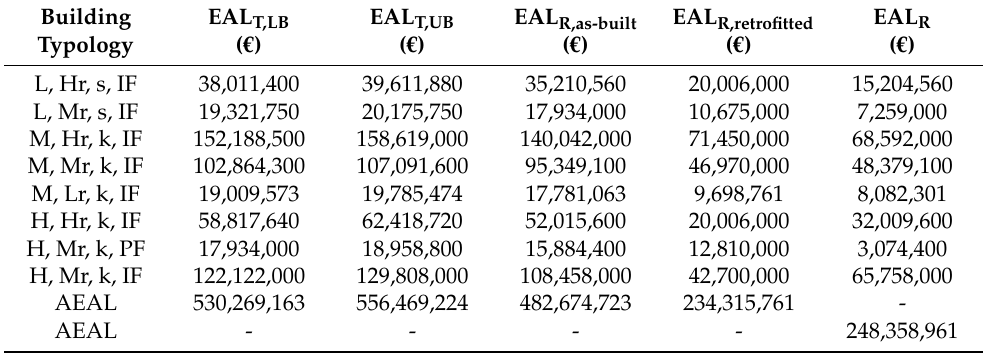
Table 12. Monetized EAL values estimated for the examined “virtual” compartments.